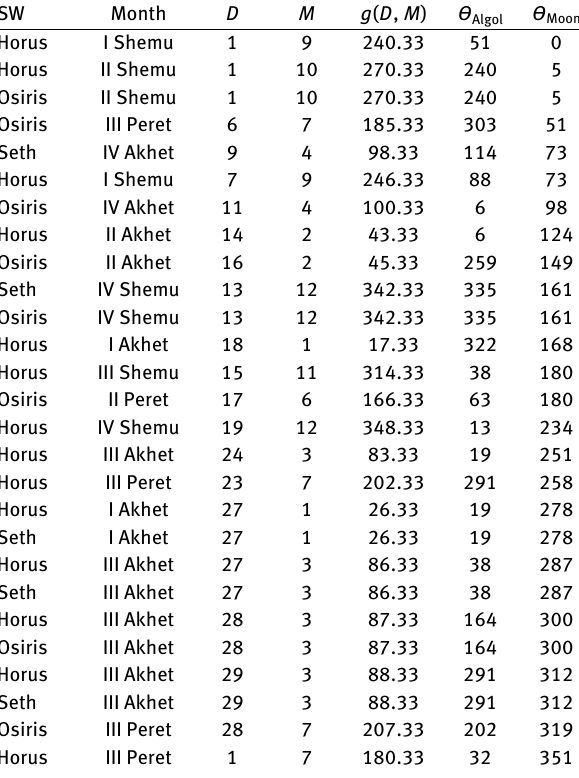
Table 3. “GGG” prognosis texts mentioning Horus, Seth or Osiris. Notations are as in Table 1, except that all values are in the order of increasing Θ Moon .